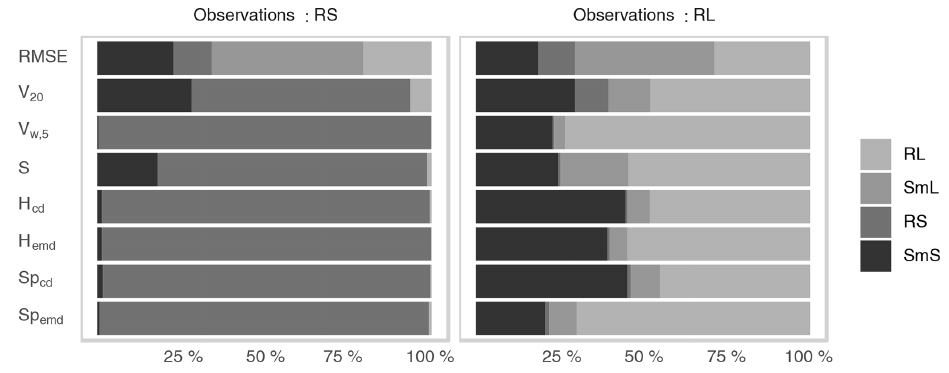
Figure 7. As Fig. 6, but for the deterministic verification experiment.